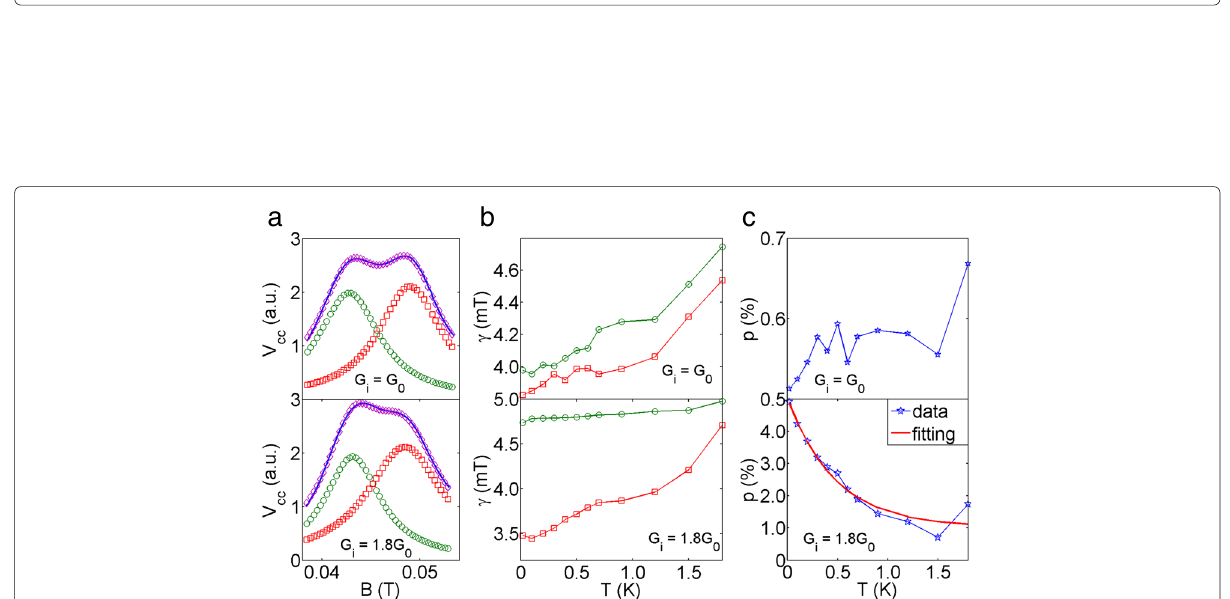
Fig. 4 Analysis of the temperature dependence data. The plots on the top are for G i = G 0 , the bottom ones are for G i = 1.8 G 0 . a Reconstructing the first focusing peak with two Lorentzian peaks at 20 mK. The solid blue line is the experimental data, the green round marker is the fit for peak I, the red square marker is the fit for peak II and the magenta diamond marker highlights the reconstructed focusing peak. b FHWM, γ as a function of temperature: the sub-peaks broaden with increasing temperature in both cases. The markers represent the same meaning as in plot ( a ). c The polarisationmeasuredwith G i = G 0 fluctuatesaround0.6%.Ontheotherhand,thepolarisationmeasuredwith G i = 1.8 G 0